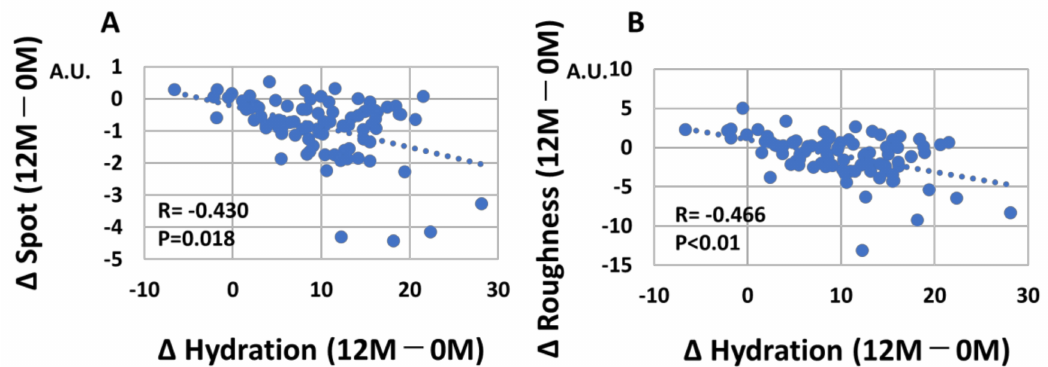
Figure 10. ( A ) Negative correlation ( p = 0.018) between ∆ skin hydration (12M–0 M) and ∆ spots (12 M–0 M). ( B ) Negative correlation ( p < 0.01) between ∆ skin hydration (12 M–0 M) and ∆ wrinkles (12 M–0